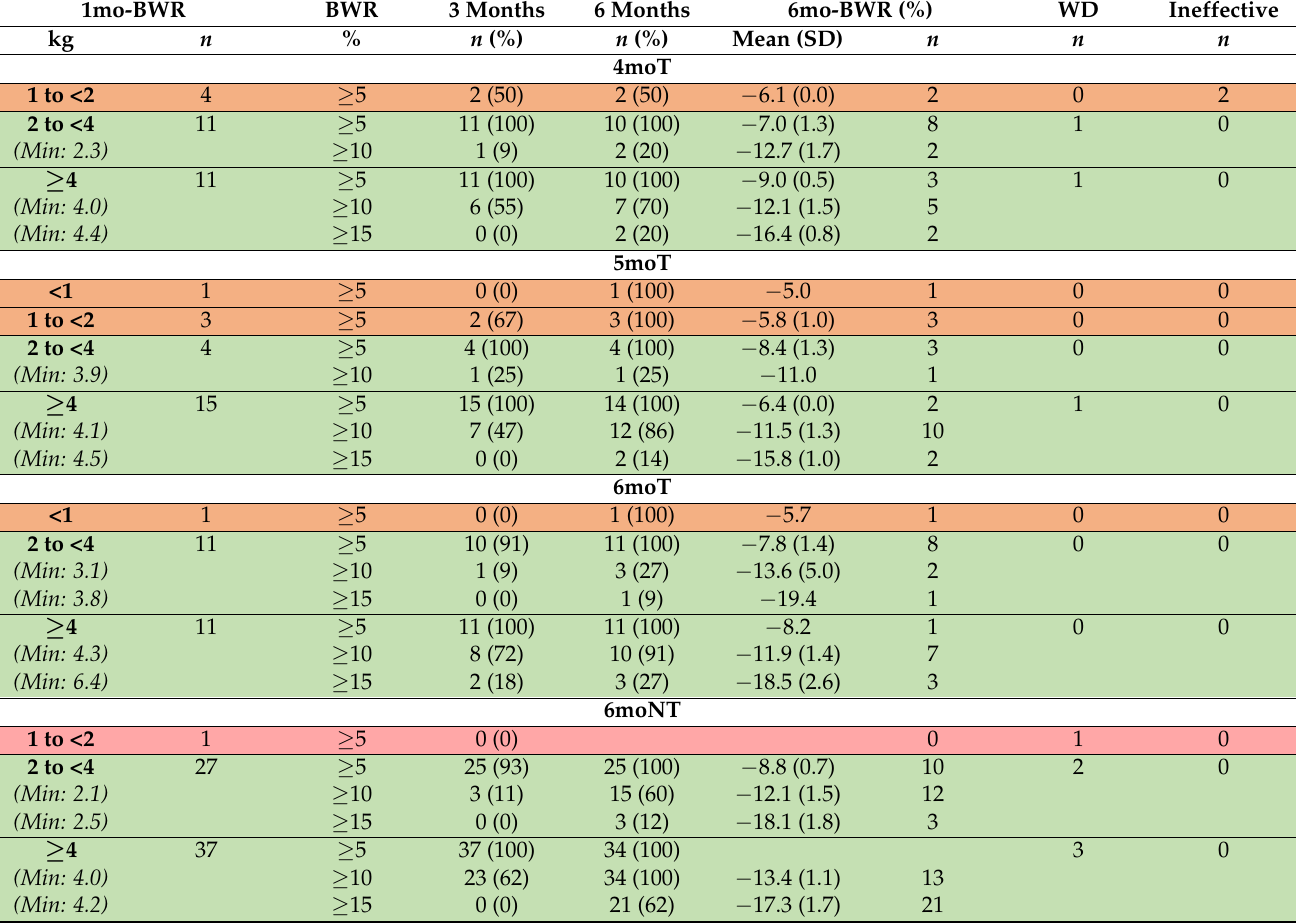
Table 3. Mazindol efficacy expectations based on late tolerance and